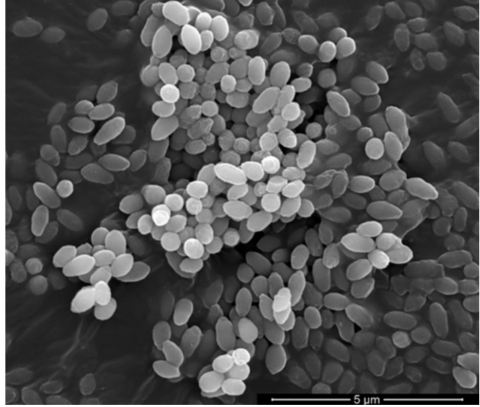
Figure 2. A field emission scanning electron micrograph of strain PS-C1 at 24,000 × magnification. Scale bar: 5 µ